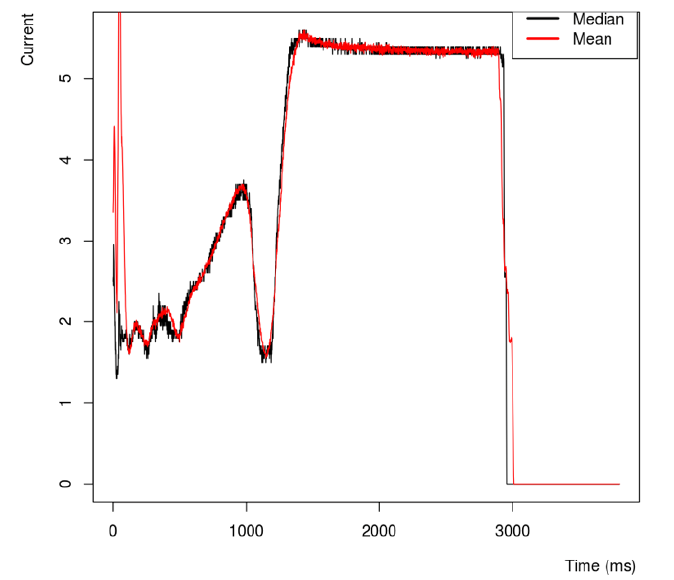
Figure 7. Current profile of a switch based on different